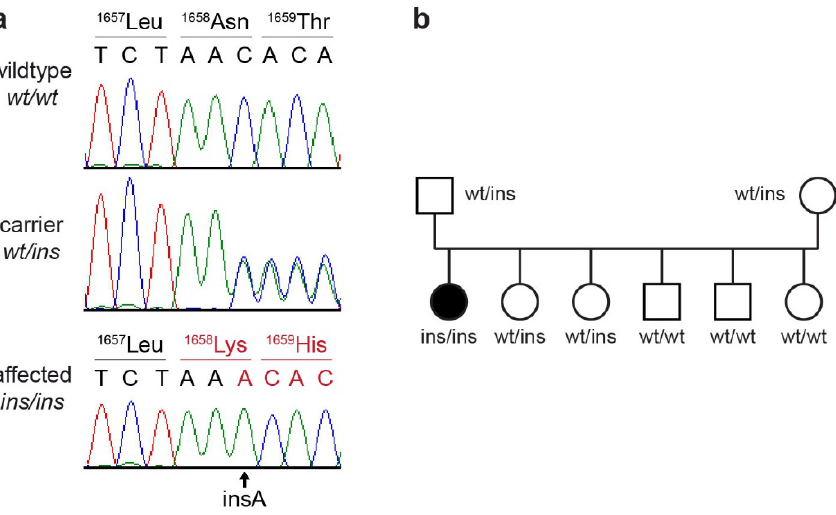
Figure 3. Details of the MYO5A :c.4973_4974insA variant. ( a ) Representative Sanger sequencing chromatograms of dogs with the three different genotypes. A homozygous insertion of a single adenine is visible in the affected dog. ( b ) The genotypes in the Dachshund family showed the expected co-segregation with the phenotype in the index family.